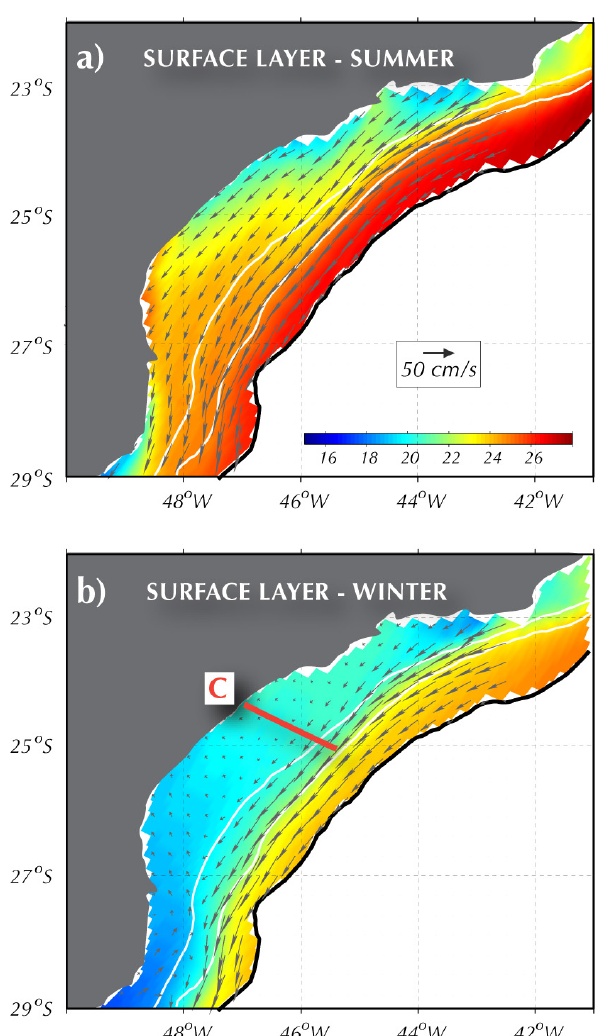
Fig. 2. Average sea surface temperatures (SSTs) and surface veloc- ities during summer (a) and winter (b) in the numerical simulation of Palma and Matano (2009). The white line marks the position of the 100m and 200m isobaths. Line C marks the location of the cross-section shown in Fig.